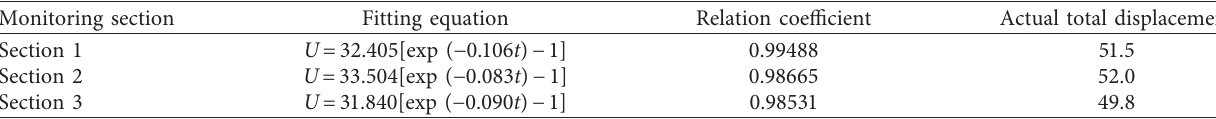
Figure 13: Actual displacement curve of the surrounding rock. Table 6: Fitting equation and actual displacement of each section.